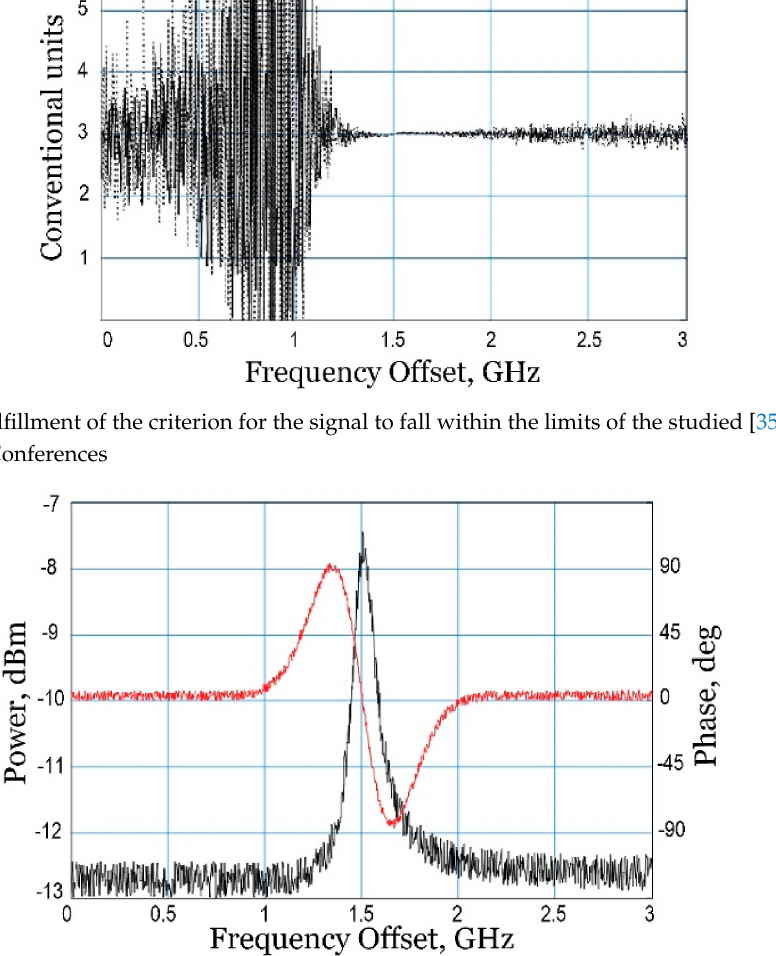
Figure16. Themeasuredmagnitude(blackline)andphase(redline)responsesoftheFanoresonance[35] © 2019 ITM Web of